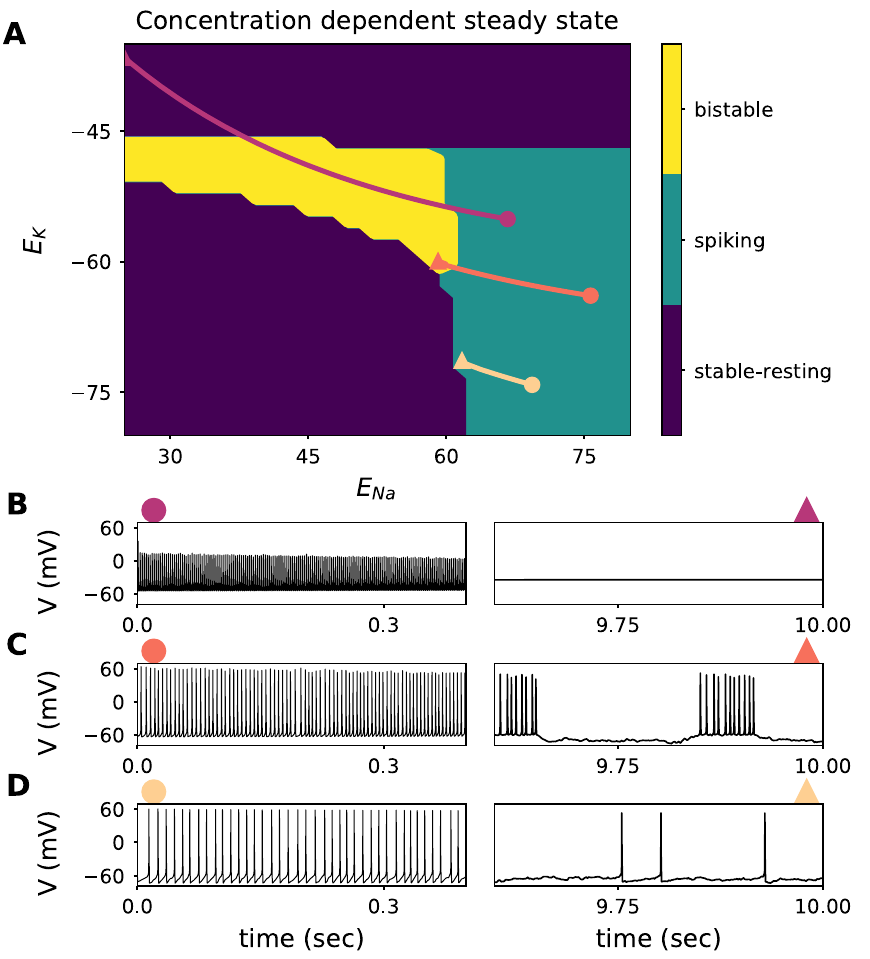
Fig 7. Consequences of simultaneous [ Na + ] and [ K + ] slow dynamics on the fast spike generating dynamics. A . i o Characteristic response of the reduced model (receiving a constant input current stimulus of 1 μA / cm 2 ) along the reversal potential plane. The characteristic response can be split in three categories; stable-resting state (purple areas in the lower left corner and top of the graph, representing the subthreshold regime and depolarization block, respectively), the spiking state (green), and the bistable state (yellow). Three example trajectories of the complete system (Including the slow activity-dependent concentration dynamics) simulated during 10 seconds with an irregular input (mean of 1 μA / cm 2 and standard deviation of 1 μA / cm 2 ). Initial conditions represented by a circle, and the state of the system 10 seconds later with a triangle. B . Membrane potential trace of the trajectory with initial conditions E = K − 55.1 mV and E Na = 66.7 mV displayed in A. Left panel shows the first 400ms of simulation (marked with a circle), and the right panel shows the last 400ms out of the 10 seconds simulation (marked with a triangle). C . Membrane potential trace of the trajectory with initial conditions E K = − 63.9 mV and E Na = 75.7 mV displayed in A. B . Membrane potential trace of the trajectory with initial conditions E = − 74.2 mV and E = 69.3 mV displayed in K Na